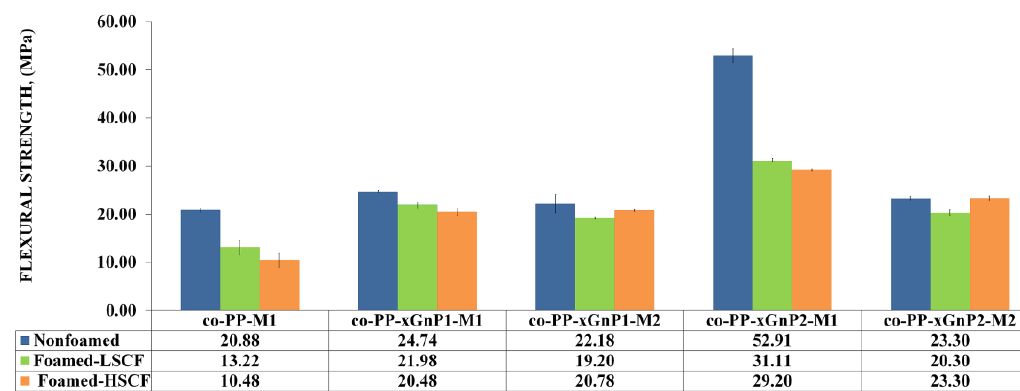
Figure 7. Flexural strength of samples.